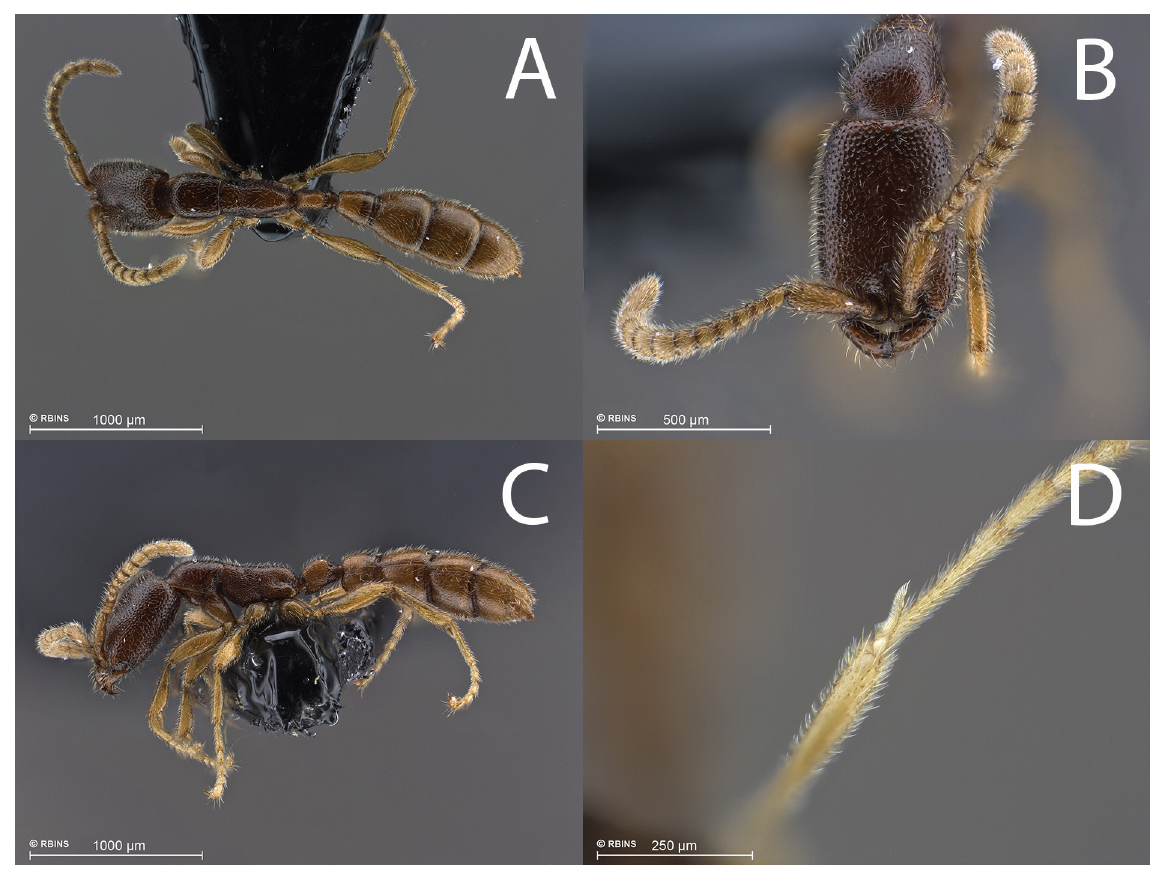
Fig. 4. Leptanilloides prometea Delsinne & Donoso sp. nov. – A–C . Paratype worker (specimen code 4052301). A . Habitus, dorsal view. B . Head in full-face view. C . Habitus, lateral view. – D . Apex of hindtibia; reservoir of metatibial gland is visible under translucent cuticle at the base of the tibial spur (paratype, specimen code